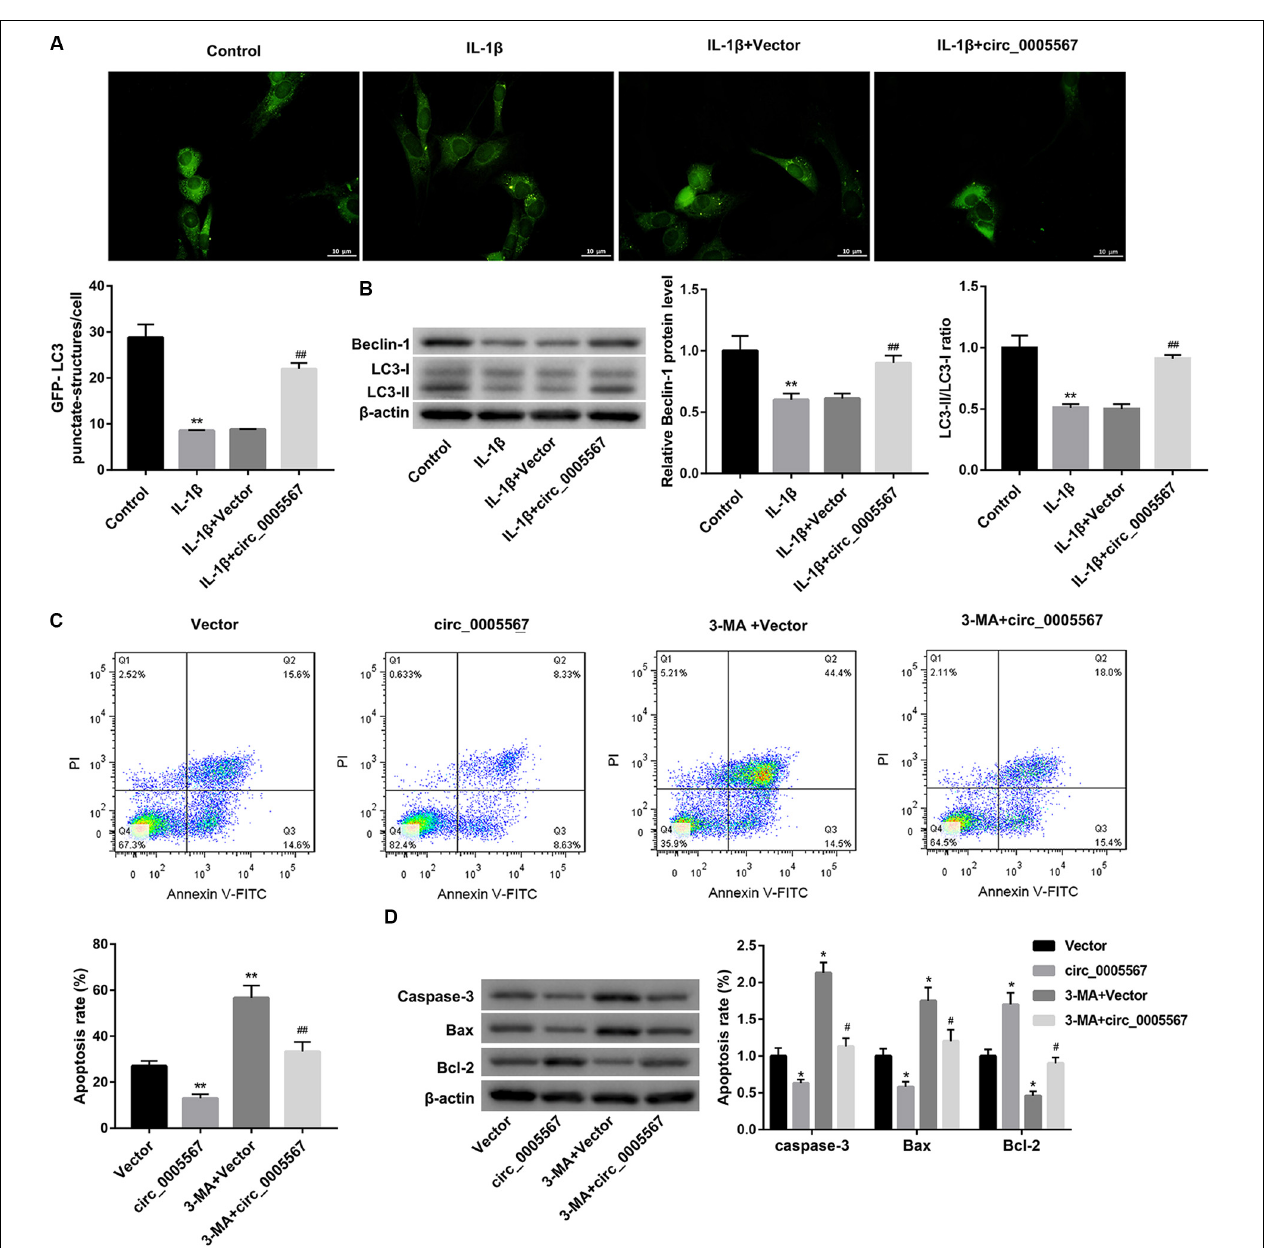
FIGURE 2 | Circ_0005567 overexpression attenuated the IL-1 β -induced chondrocyte apoptosis by inducing autophagy. (A) Immunofluorescence results of chondrocytes transfected with GFP-LC3 and (B) protein levels of Beclin-1 and LC3-II/LC3-I examined by western blot in chondrocytes transfected with circ_0005567 overexpression vector (circ_0005567 group) or empty vector in the presence of PBS (control) or IL-1 β . (C) Cell apoptosis rate determined by flow cytometry after Annexin V-FITC/PI staining and (D) protein levels of caspase-3, Bax, and Bcl-2 examined by western blot in IL-1 β -treated chondrocytes in the